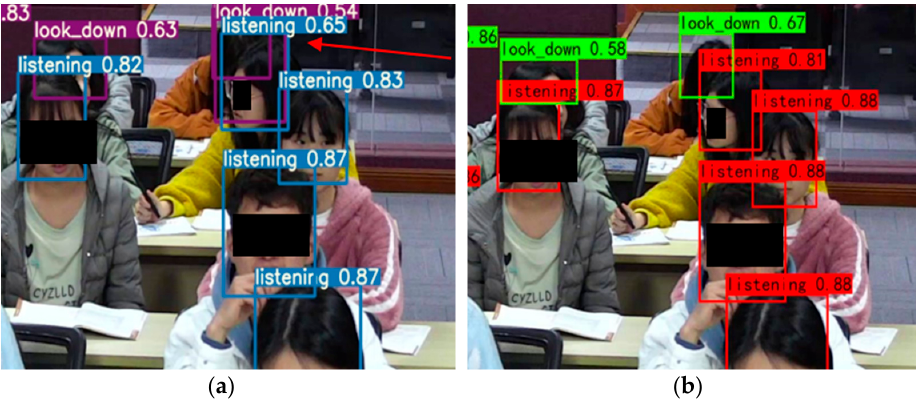
Figure 16. Comparison of occlusion scene detection effects. ( a ) YOLOv5. ( b ) Ours.